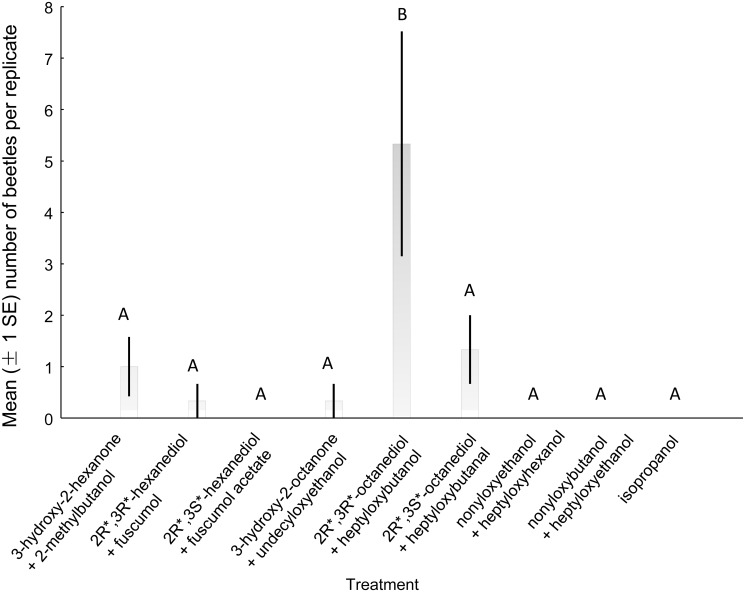
Mean (± 1 SE) numbers of adult male and female Anoplophora chinensis captured by traps baited with synthetic pheromone in Nanjing, China.Chemical abbreviations: alcohol, 4-(n-heptyloxy)butan-1-ol; aldehyde, 4-(n-heptyloxy)butanal. Within each sex, different letters indicate significant differences between pairs of treatments (Duncan’s range test, P > 0.05).